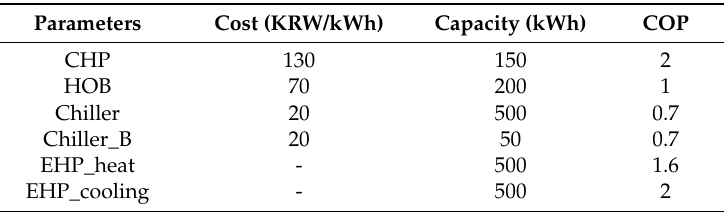
Table 1. Input parameters for energy supply facilities.